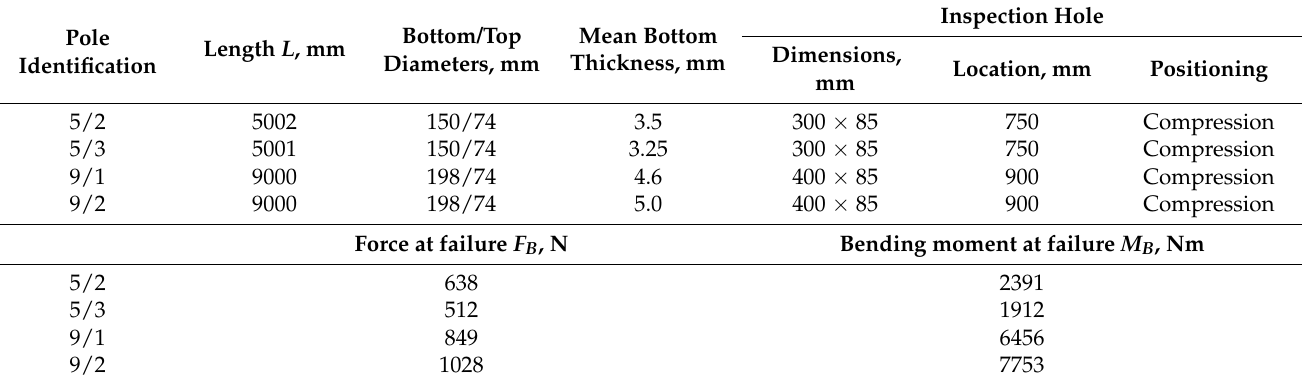
Table 3. Dimensions of tested poles and the experimental failure loads.